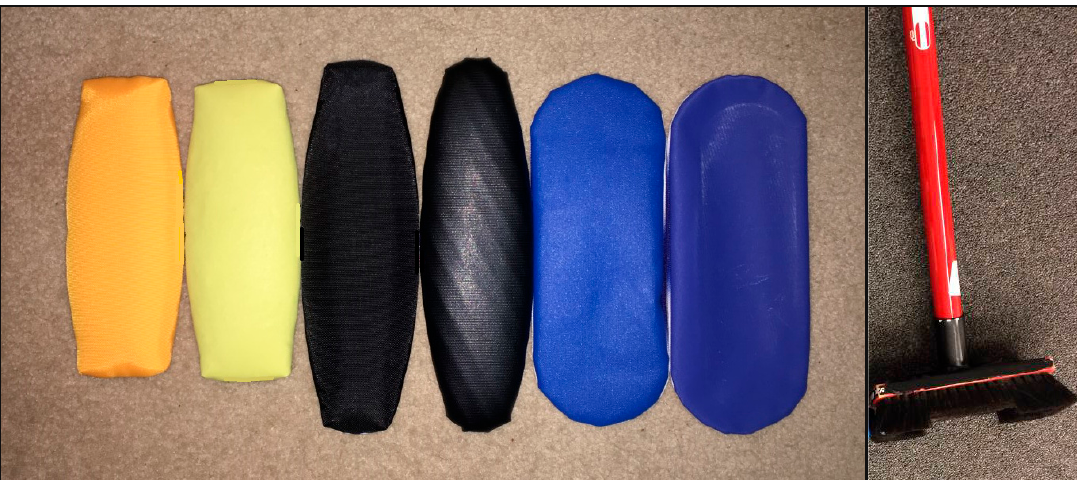
Figure 2. Brooms from left to right—A1, A2, B1, B2, C1, C2, and short hair brush. At the time of this experiment, broomhead A1 was the only synthetic material approved for play in all World Curling Federation (WCF) events.